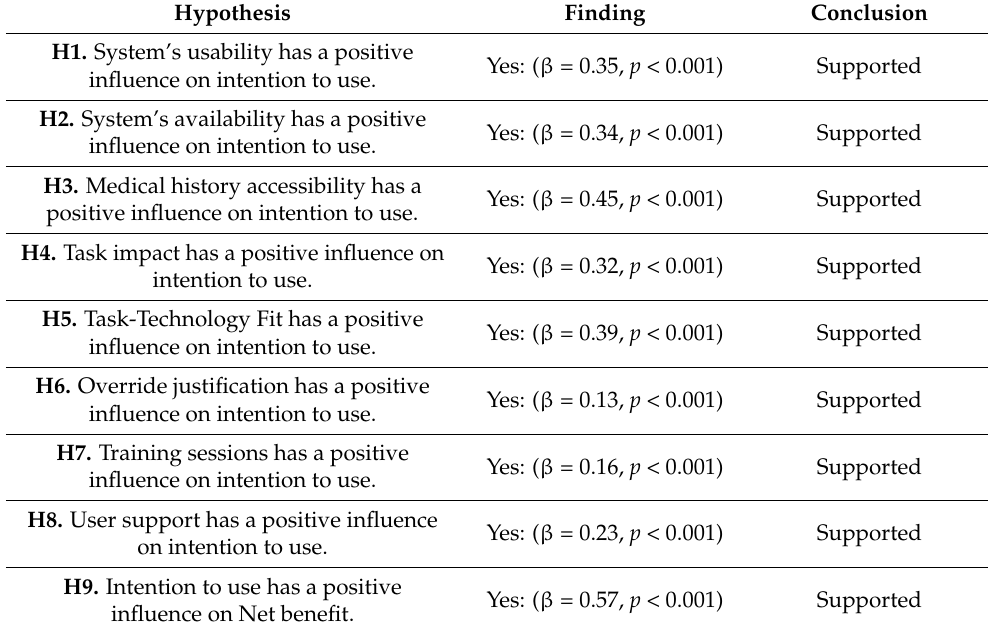
Table 6. Hypothesis